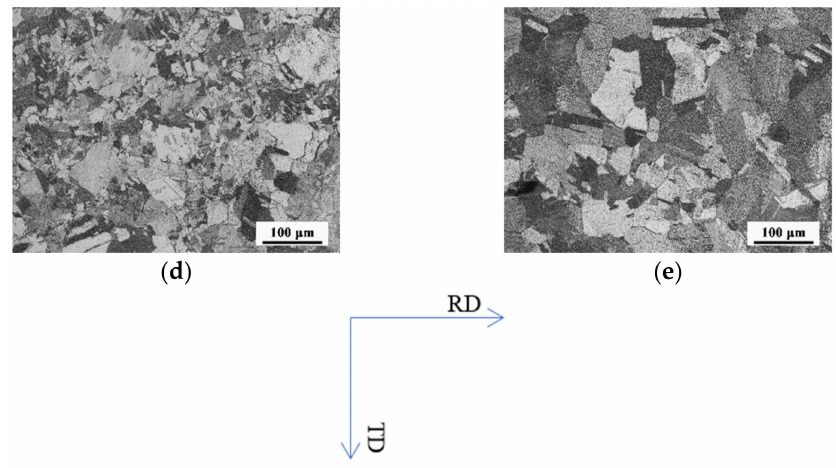
Figure 1. Optical micrograph of Ag with the rolling plane: cold rolled ( a ) and following annealing at 300 °C ( b ), 400 °C ( c ), 500 °C ( d ), 600 °C ( e ), respectively (TD: Transverse direction, RD: Rolling direction).